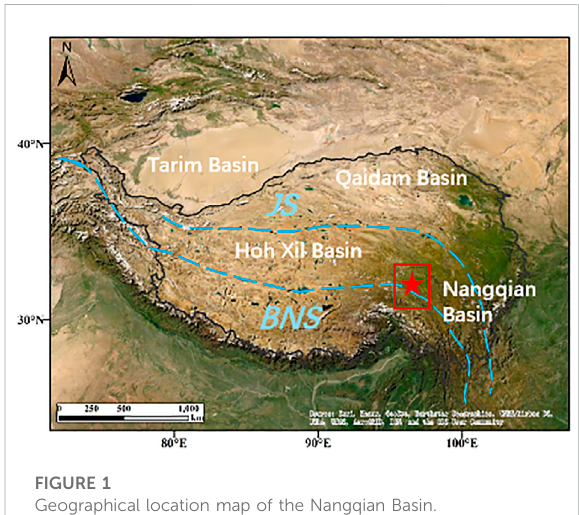
FIGURE 1 Geographical location map of the Nangqian